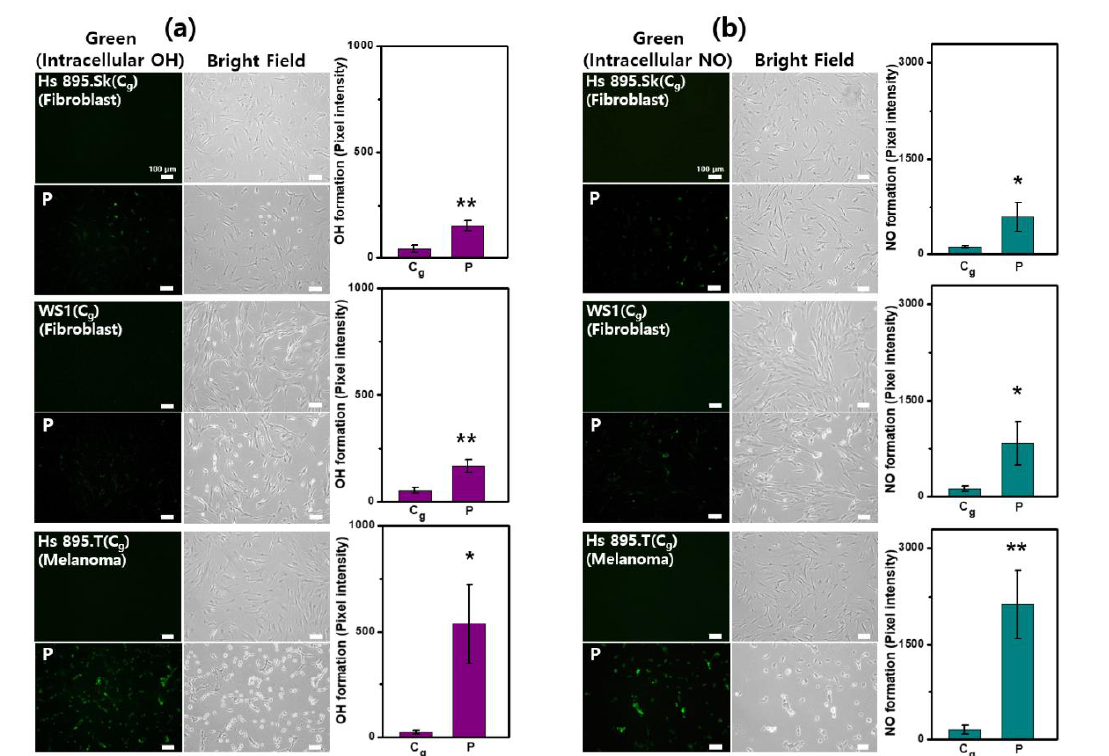
Figure 6. CAP induces the increased level of intracellular OH and NO in cancer cells. Fluorescence images (green: intracellular ( a ) •OH and ( b ) NO) and intensity graphs of intracellular RONS production, and brightfield images in gas-treated control and CAP-treated cells: ( a ) hydroxyl radical (•OH) (upper row, Hs 895.Sk (fibroblasts); middle row, WS1 (fibroblasts); bottom row, Hs 895.T (melanoma)) and ( b ) nitric oxide (NO) (upper row, Hs 895.SK (fibroblasts); middle row, WS1 (fibroblasts); bottom row, Hs 895.T (melanoma)). Each point represents the mean ± SD of three replicates. Scale bar indicates 100 μm. *, p < 0.05; **, p < 0.01. * p < 0.05 was considered statistically significant.